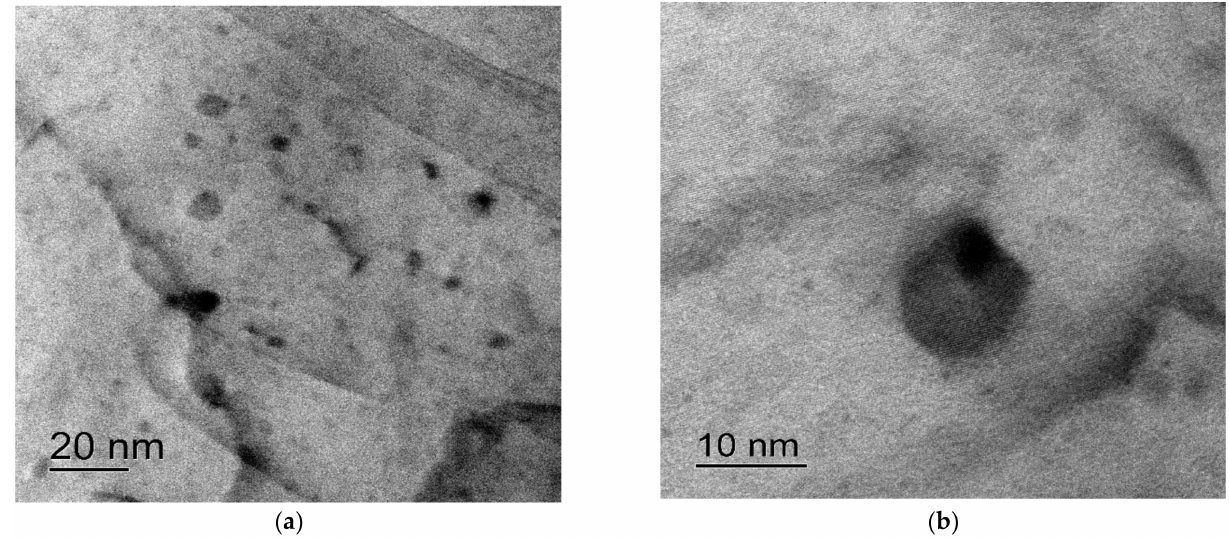
Figure 15. Nucleation of the Al 3 Zr intermetallide nanoparticles in the annealed wire made from Alloy #2. TEM. ( a ) small zooming; ( b ) large